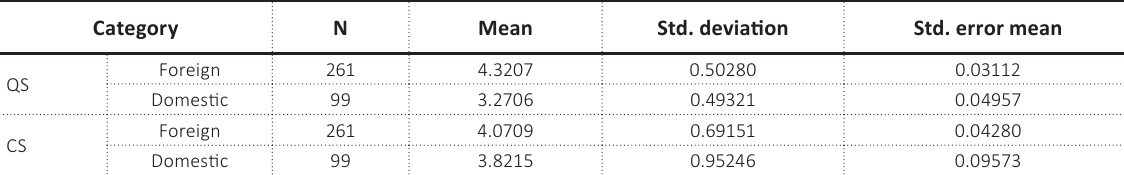
Table 7. Descriptive analysis of service quality and customer satisfaction